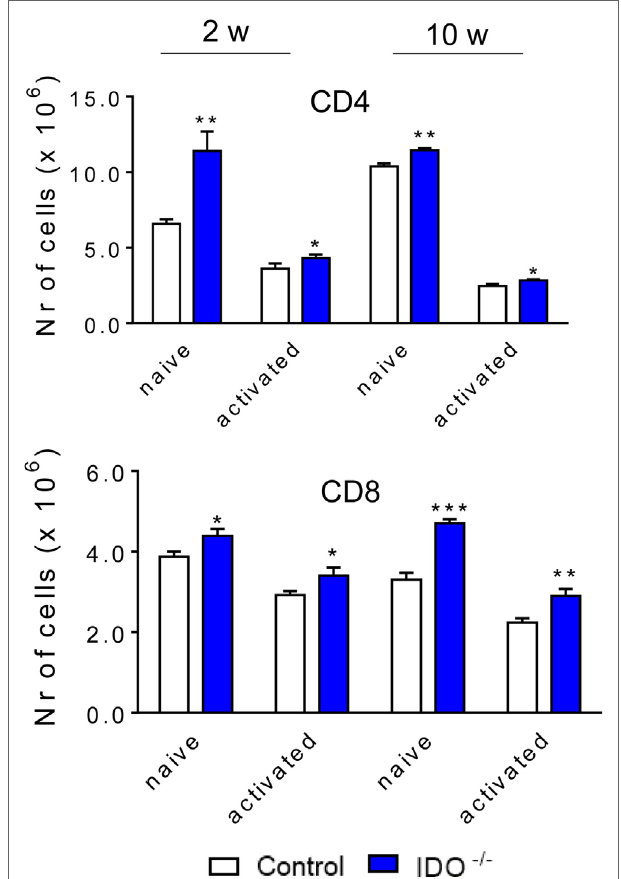
FigUre 6 | The absence of indoleamine 2,3 dioxygenase-1 (IDO1) induces an increased influx of naïve and activated TCD4 + and TCD8 + lymphocytes to the lungs. The phenotypic analysis of lung infiltrating lymphocytes from wild-type and IDO1 − / − mice was performed at 2 and 10 weeks of Paracoccidioides brasiliensis infection. The lung cells were obtained as described in Section “Materials and Methods” and labeled with antibodies conjugated to different fluorochromes. The lung infiltrating leukocytes were gated by FSC/SSC analysis. The cells were then gated for CD4 + or CD8 + expression and for membrane markers that characterize naïve and effector/ activated cells (CD44 low CD62L high and CD44 high CD62L low , respectively). For gate strategy, see Figures S1 and S2 in Supplementary Material. One hundred thousand cells were acquired on FACS CANTO II and subsequently analyzed by FlowJo software. Data are expressed as means ± SEM and are representative of three independent experiments using five mice of each mouse strain per group (* p < 0.05; ** p < 0.01, and *** p < 0.001).